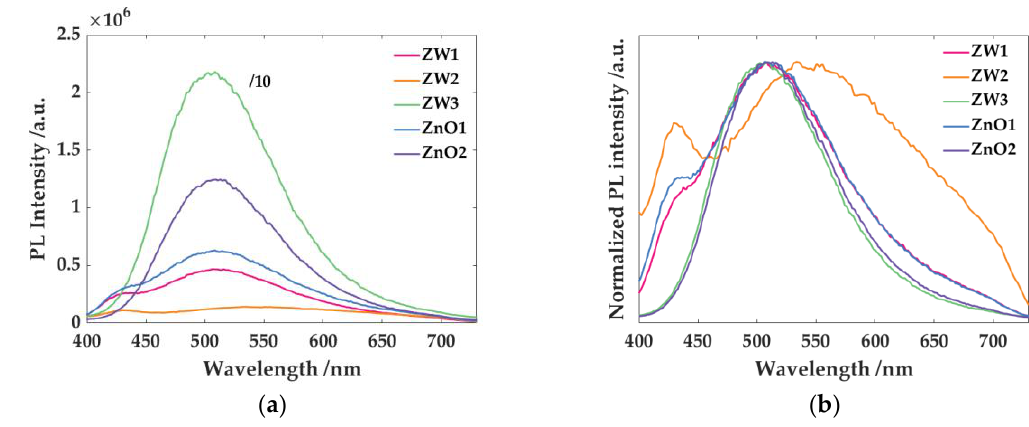
Figure 2. ( a ) Trap-assisted emission of zinc white and zinc oxide samples, acquired with a gate window of 10 μs and a delay of 0.5 μs. ( b ) Spectra are shown normalized at the emission maximum, for better appreciating the relative peak position and the shape of the emissions.